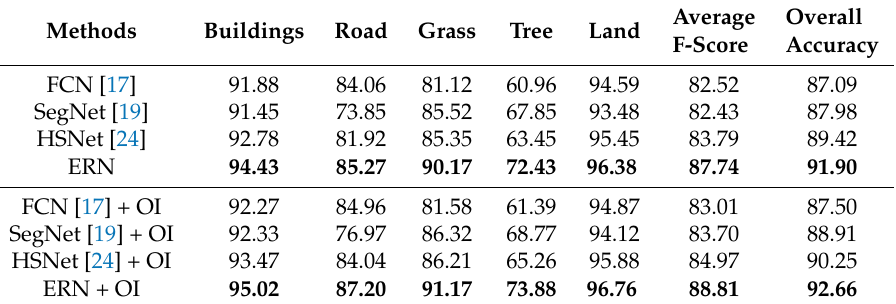
Table 4. Experimental results on the UAV image dataset. OI: overlap